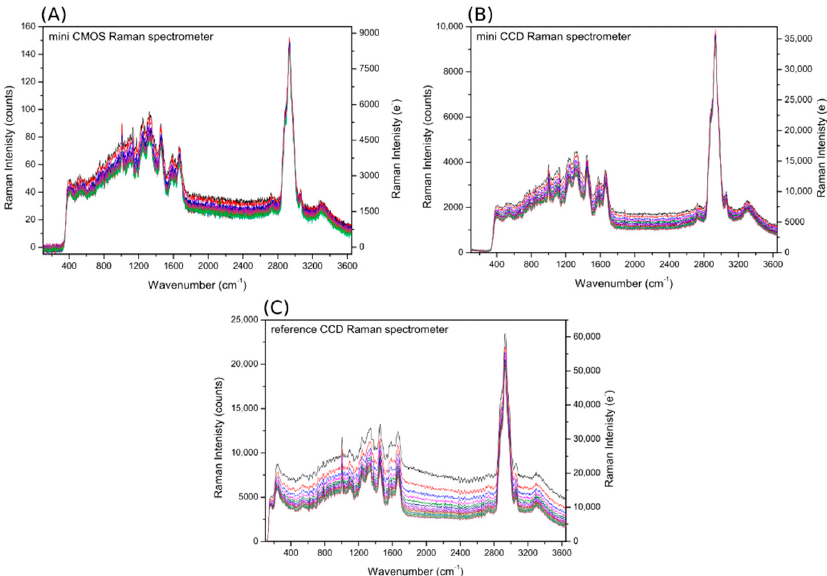
Figure 2. Raman spectra of E. coli DSM 423 bacteria measured with ( A ) the mini CMOS Raman spectrometer, ( B ) the mini CCD Raman spectrometer and ( C ) the reference CCD Raman spectrometer at a single position on the surface of the aluminum substrate. The spectrum plotted in black is the first spectrum in the series, while the green one is the last spectrum.